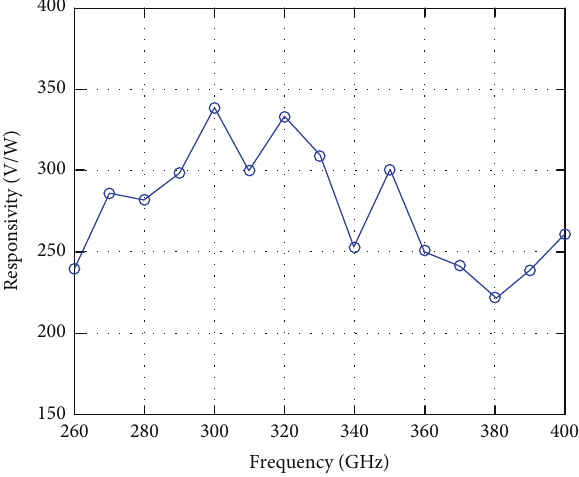
Figure 14: Voltage responsivity for one channel of